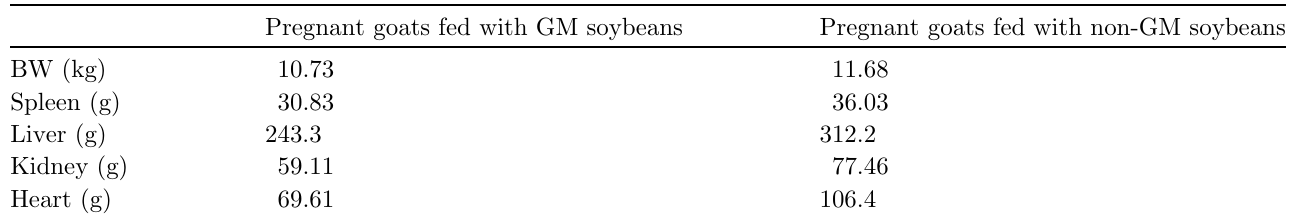
Table 1. The situation of pregnant goats fed with GM soybeans and fed with non-GM soybeans. Pregnant goats fed with GM soybeans Pregnant goats fed with non-GM